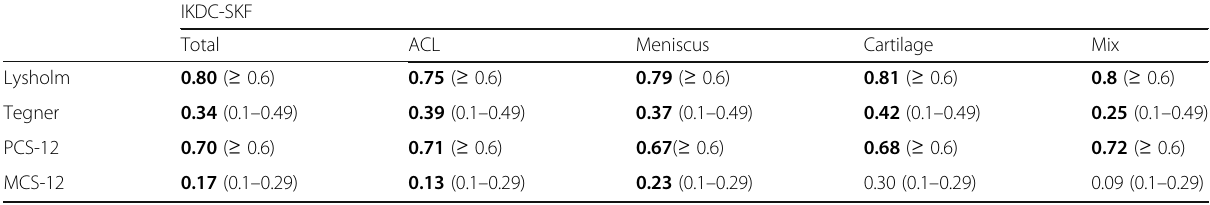
Table 3 Hypothesis testing for evaluating validity of the IKDC-SKF for the total population as well as each patient subgroup IKDC-SKF Meniscus